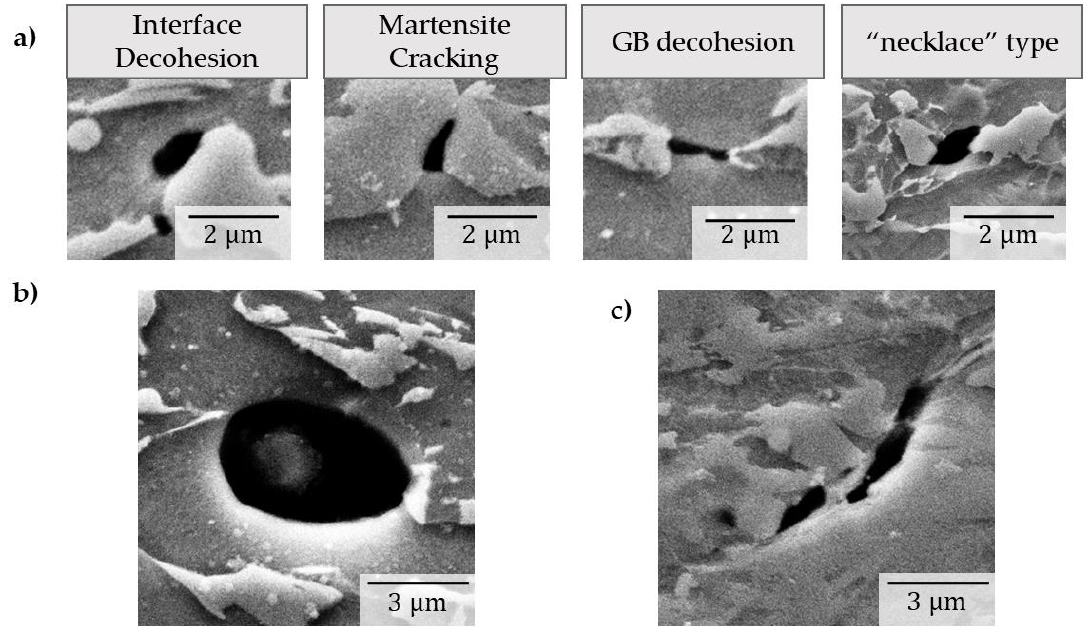
Figure 4. ( a ) Examples of fundamental damage mechanisms of martensite/ferrite interface decohesion, martensite cracking, ferrite grain boundary (GB) decohesion and “necklace” type voids between two adjacent martensite particles; ( b ) void observed due to (partly) removed inclusions from the surface, recognized by a deep learning algorithm; ( c ) void coalescence near the outer surface of an air bending sample.